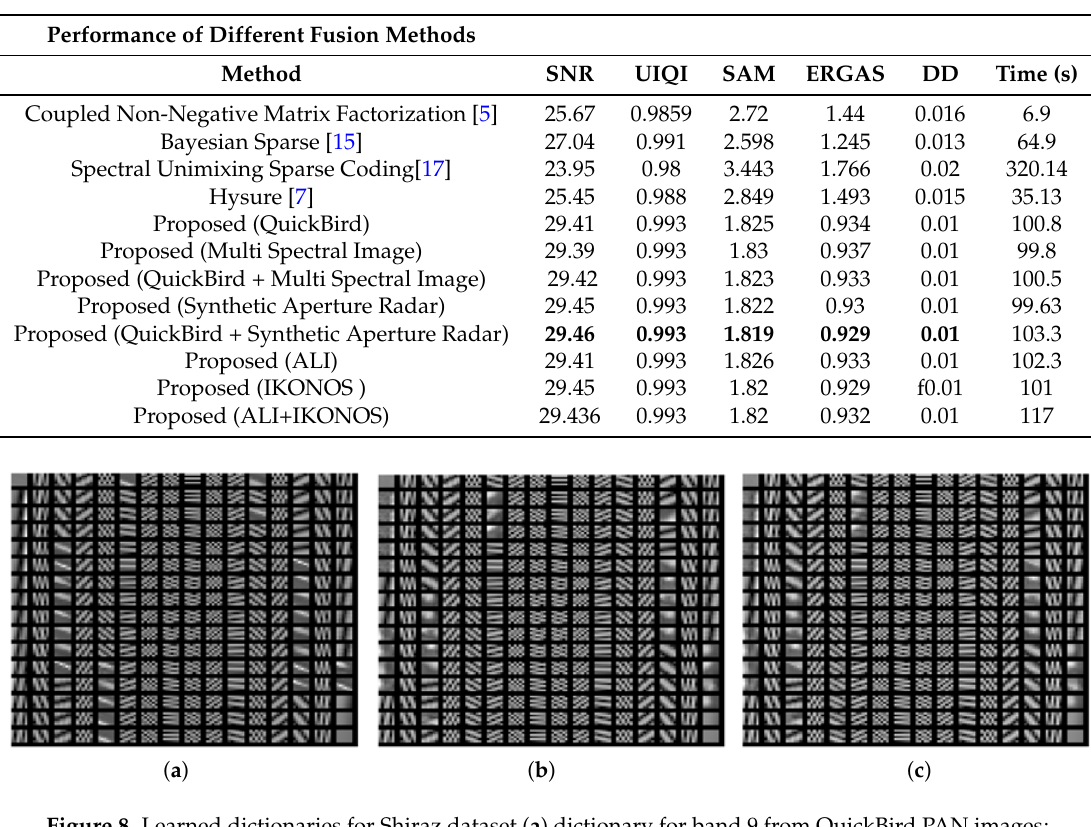
Figure 8. Learned dictionaries for Shiraz dataset ( a ) dictionary for band 9 from QuickBird PAN images; ( b ) dictionary for band 9 from MSI; ( c ) weighted dictionary ( α = 0.9, β = 0.3